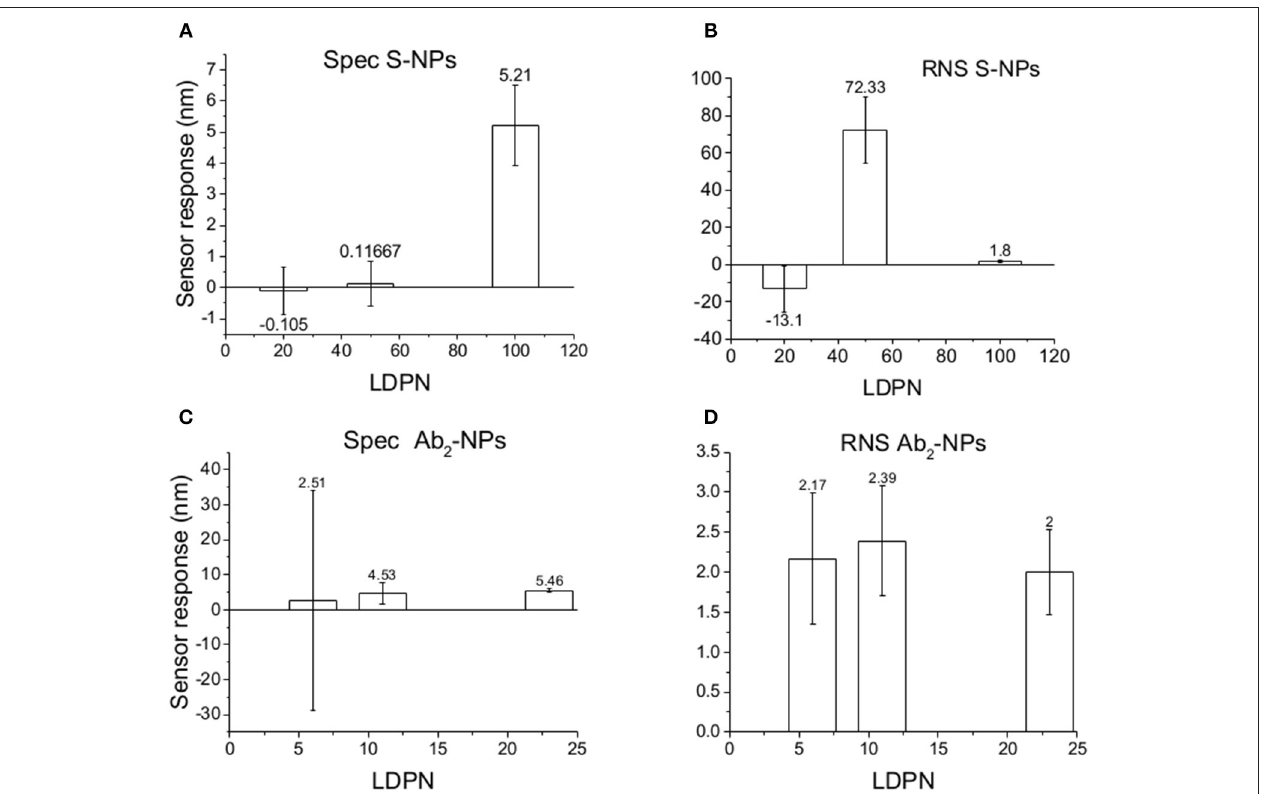
FIGURE 8 | Specific SPR sensor responses to S-NPs (A) and Ab 2 -NPs (C) and relative non-specific SPR sensor response (RNS) to S-NPs (B) and Ab 2 -NPs (D) as a function of LDPN. The data were calculated as the mean values of SPR sensor responses at the equilibrium taken from at least 3 measurements. Measurements were performed in blood plasma diluted to 30% with PBS BSA